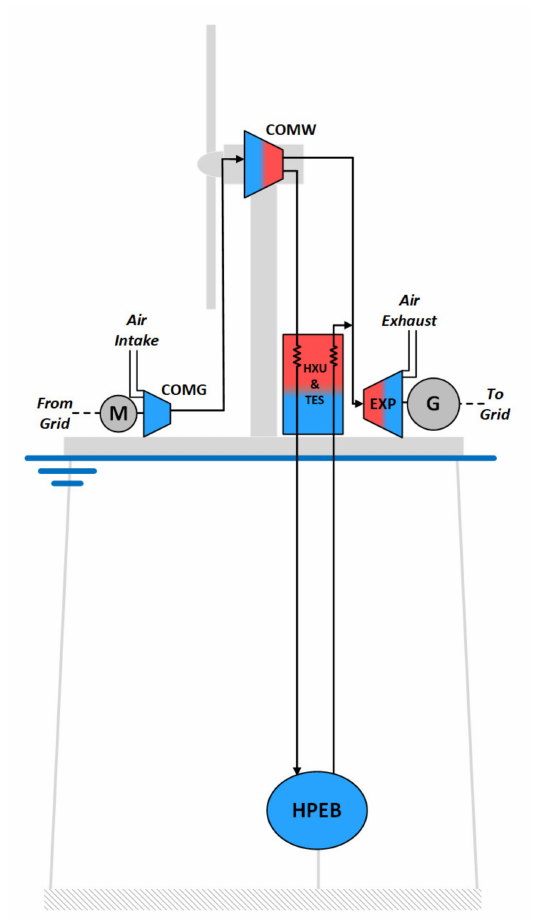
Figure 4. The Wi-DACIS system in an adiabatic main stage configuration. In an isothermal configura- tion, HXU and TES are not